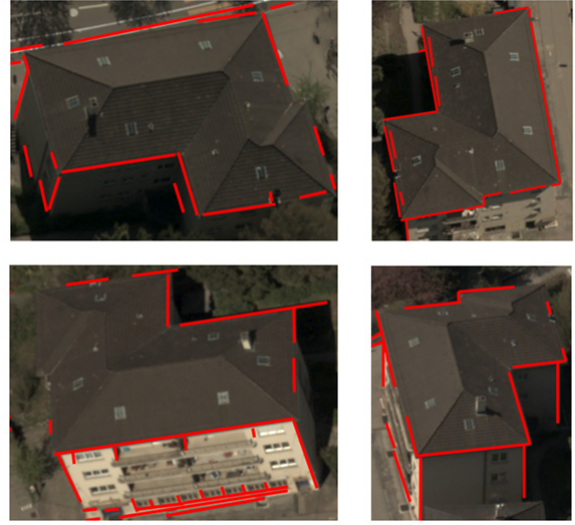
Fig.6. Different candidate lines of multi-view images To solve the problem of how to determine the new positions of boundary lines, we take two operations to transform boundary lines: translation and decomposition. In general, translation is the major operation that each boundary line has different translations to its nearly parallel candidate lines. During the translation, the same parts of two lines can be calculated and then used to determine the decomposition operation. As in figure 7(a), both two cases contain two translations from Line L to L1 and L2, but their corresponding line parts are different. The left is the case that two corresponding parts P1 and P2 include each other, while the right case shows that P1 and P2 are connected or away from each other, but constitute the approximate shape of line L, which is promising to need the line decomposition . To make the further judgment of the right case, we also search orthogonal candidate lines to find the short line L3 between L1 and L2. If L3 found, line L will be decomposed at the position of L3, otherwise, the dividing position is determined by the midpoint of two neighbor end points. Figure 7(b) shows that the projected boundary line a1 should be decomposed into four line segments b1,b2,b3,b4, while orthogonal lines c1,c2,c3 are added to connect translated